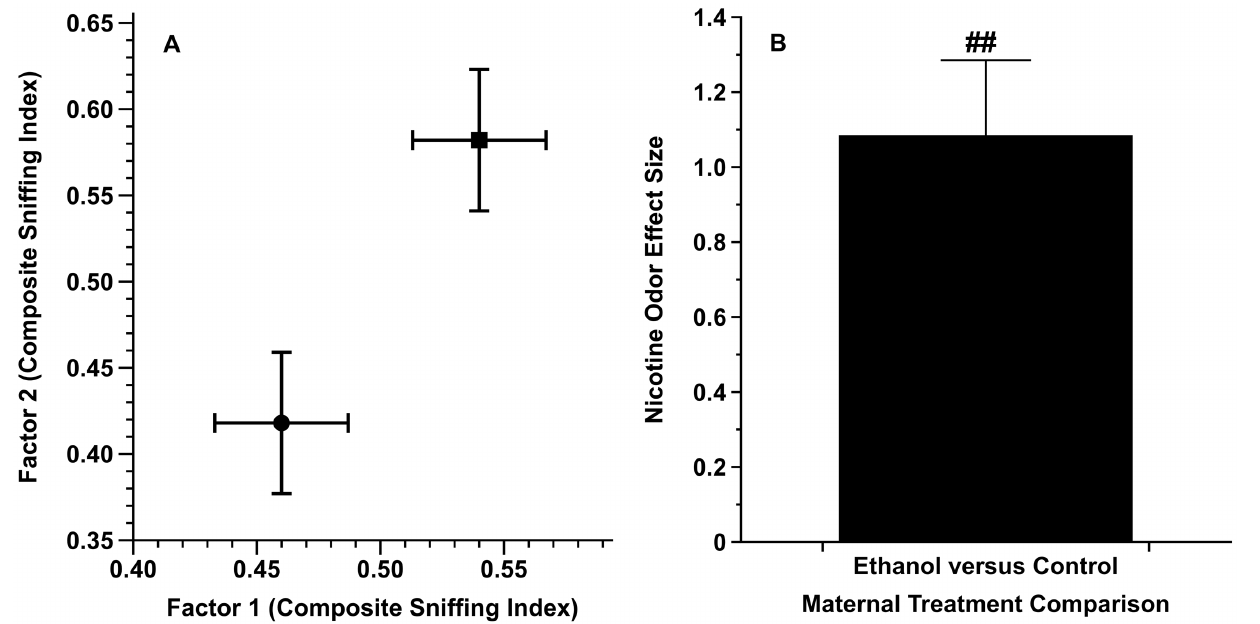
Figure 1. The consequence of prenatal alcohol exposure on the innate odor-mediated behavioral response to nicotine. Panel A illustrates the comparative location of the prenatal alcohol- versus control-exposed groups in a nicotine odor-mediated behavioral response space. The data points are the adjusted least square mean sniffing indexes ( 6 two-dimensional se) as a function of the two prenatal treatments (Solid circles=alcohol exposed; Solid squares=control exposed). Panel B shows the nicotine response-mediated weighted effect size (mean 6 se) calculated from the data illustrated in Panel A. ## = P , 0.03; see text for details.